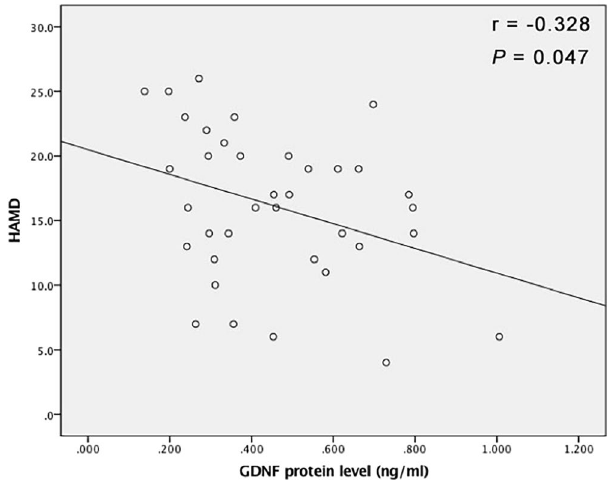
Figure 1. The correlation analysis showed that GDNF protein level negatively correlated with the value of HAMD-17 in PSD patients (correlation coefficient = − 0.328, P = 0.047). Abbreviations: GDNF, glial cell line- derived neurotrophic factor; HAMD, Hamilton depression rating scale; PSD, post stroke depression.